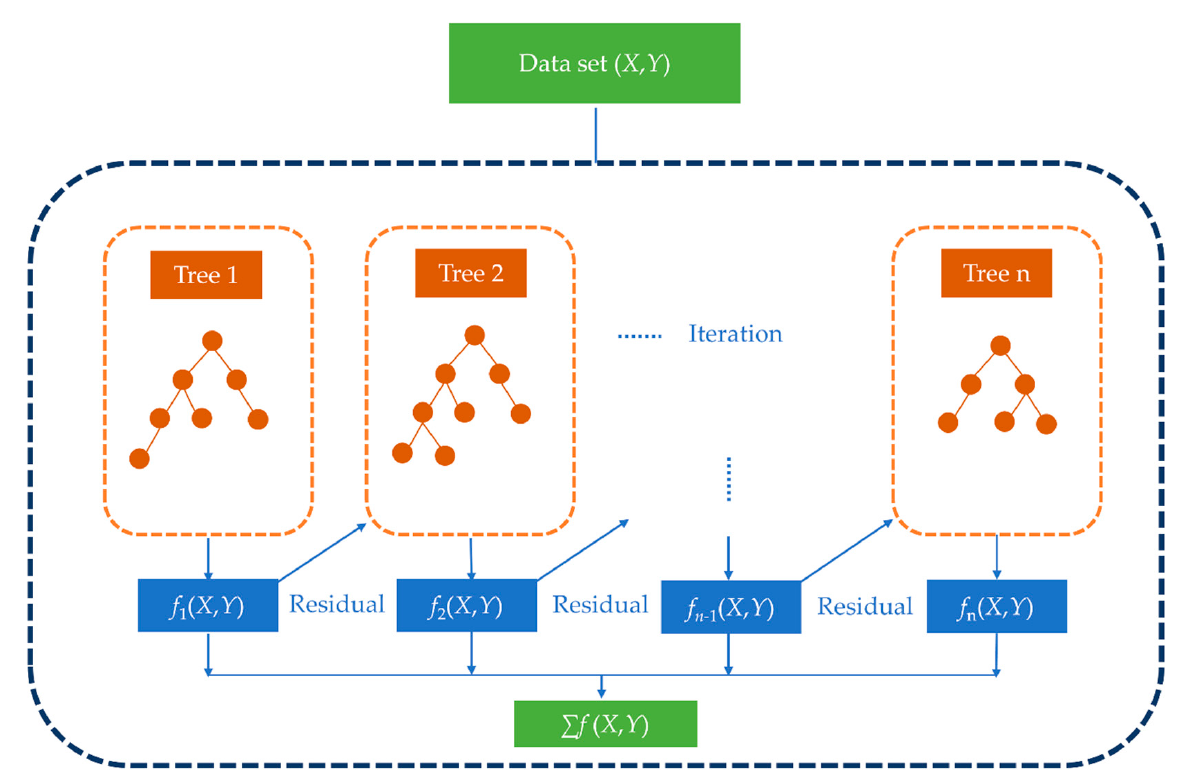
Figure 4. Framework of the Extreme Gradient Boosting model (XGBoost). f n-1 ( X,Y ) and f n ( X,Y ) are the predicted values for n and n -1 iterations.